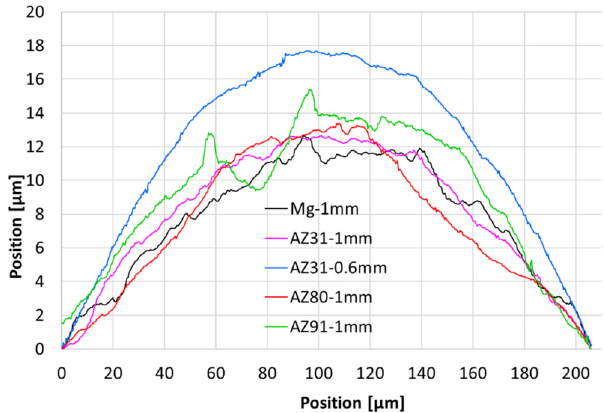
Figure 8. Surface contour measurements for the wires from illustrations in 500 × magnification in Figure 7.